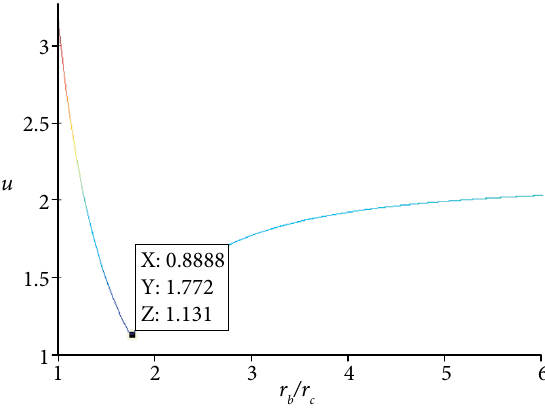
Figure 15. The relation between the parameters u and r